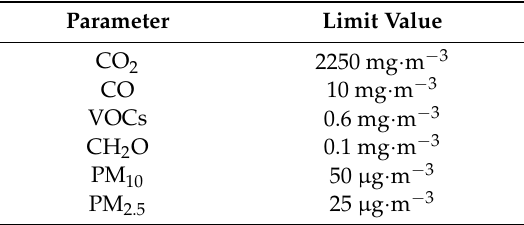
Table 3. Limit values of indoor air pollutants established by the Portuguese Ordinance no. 353-A/2013 [32] regarding a daily mean of eight hours.